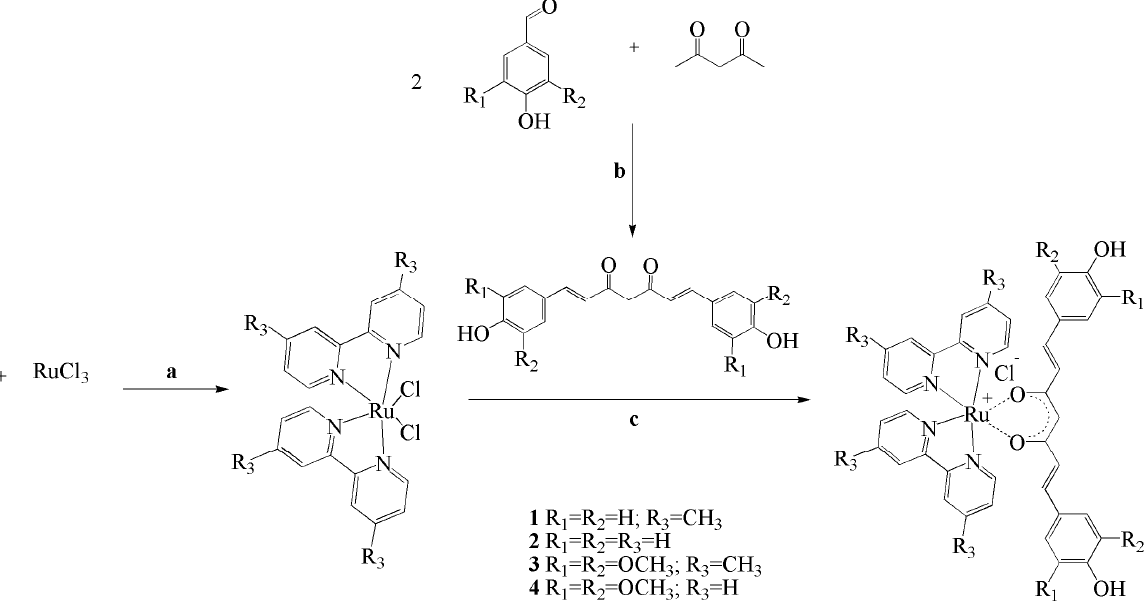
Figure 1. Scheme of preparation of ruthenium complexes with bisdemethoxycurcumin and syringaldehyde curcumin; a —DMF, 5 h reflux, b —B 2 O 3 , (nBuO) 3 B, nBuNH 2 , HCl, c —DMF/H 2 O, Na 2 CO 3 , 3h reflux.